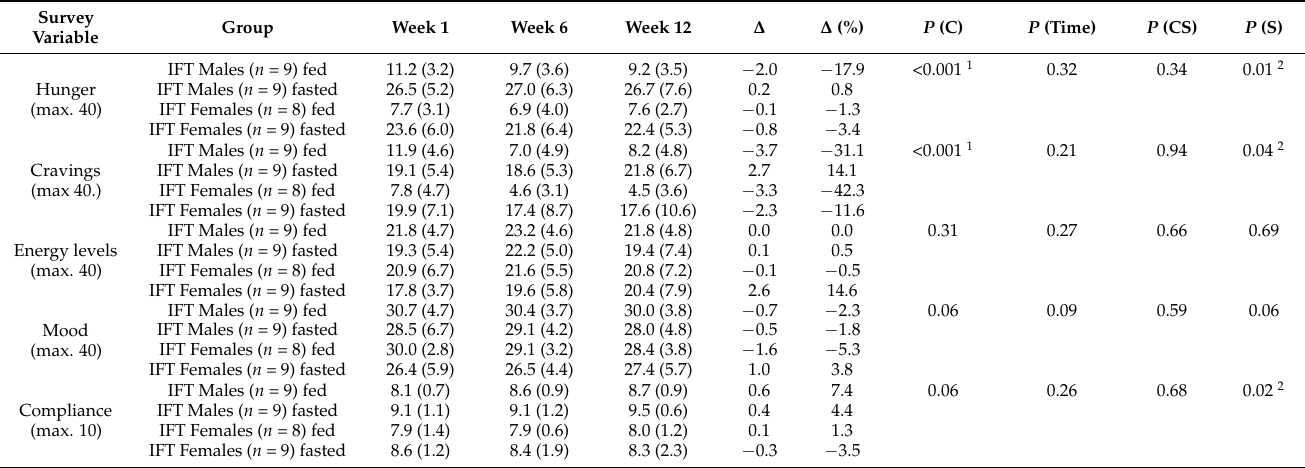
Table 6. Mean ratings for hunger, cravings, energy levels, mood and compliance separated by fasting and fed days in IFT participants over 12 weeks.